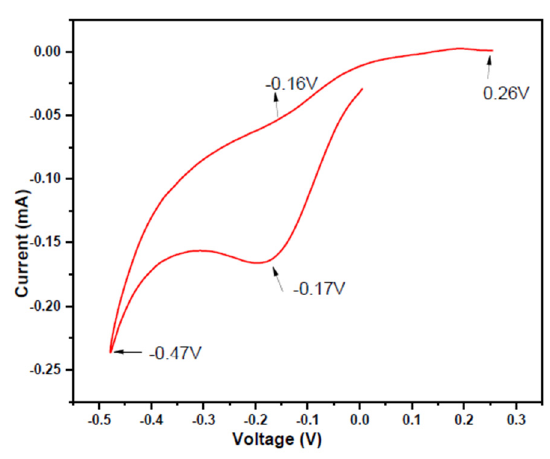
Figure 4. Cyclic Voltammogram of 0.1 mM HTeO 2+ at scan rate of 50 mV/s versus Pt tip working electrode and Ag/AgCl as a reference electrode.